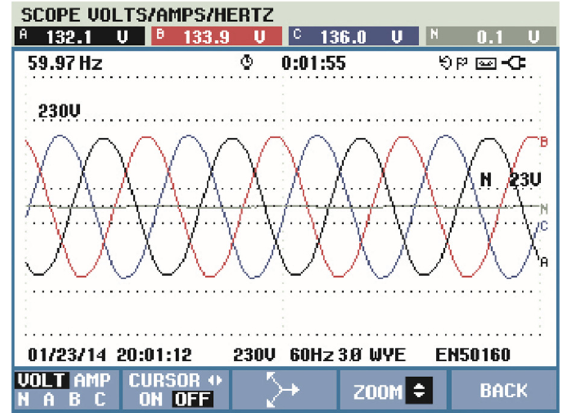
Figure 20. Source voltage measured using the Fluke energy analyzer.